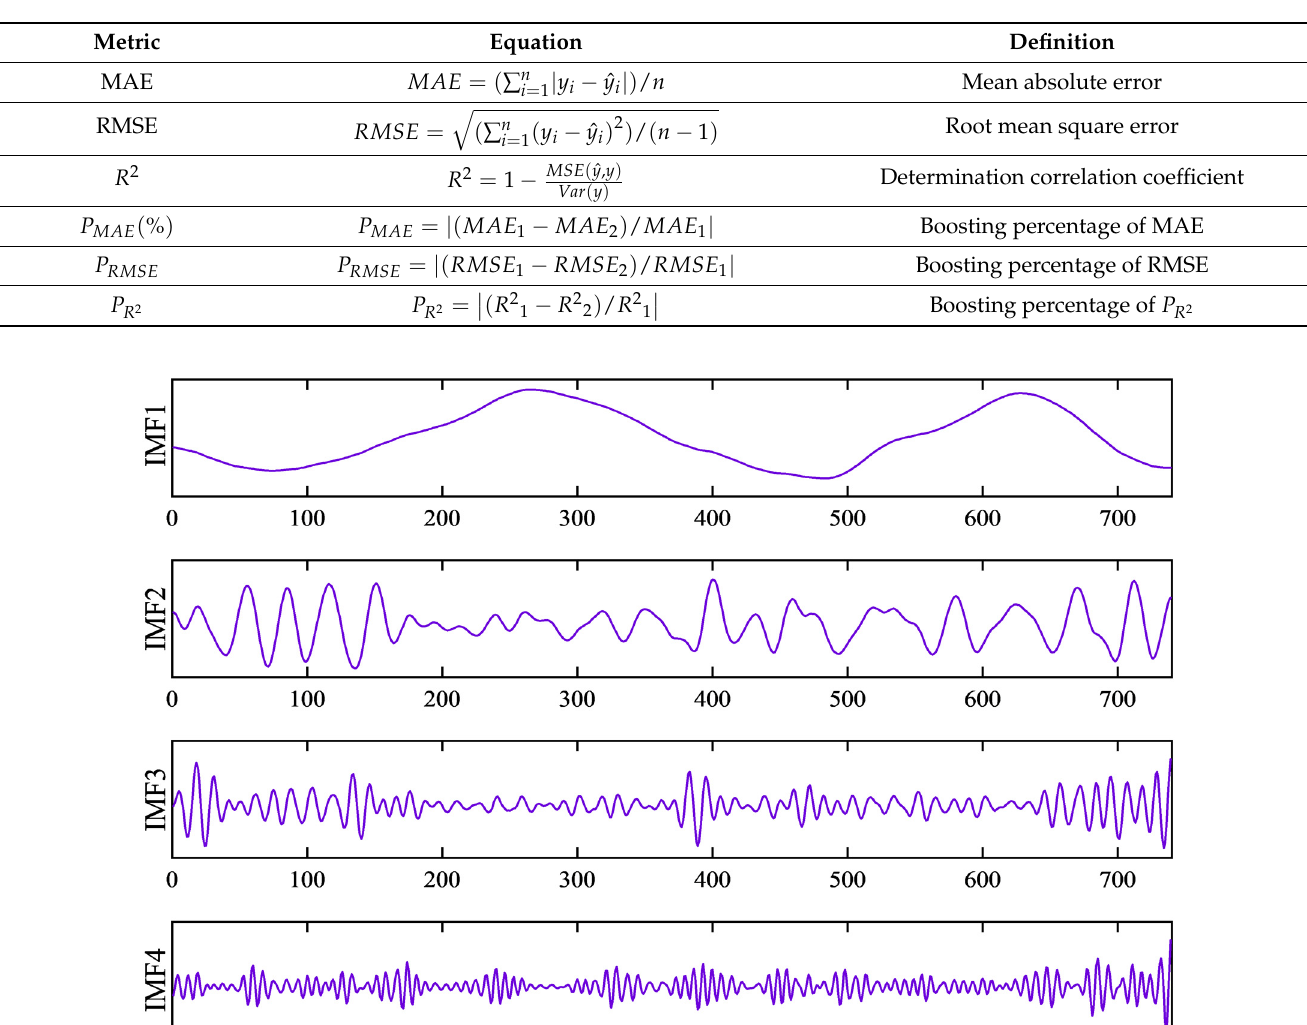
Table 2. Evaluation index formula.